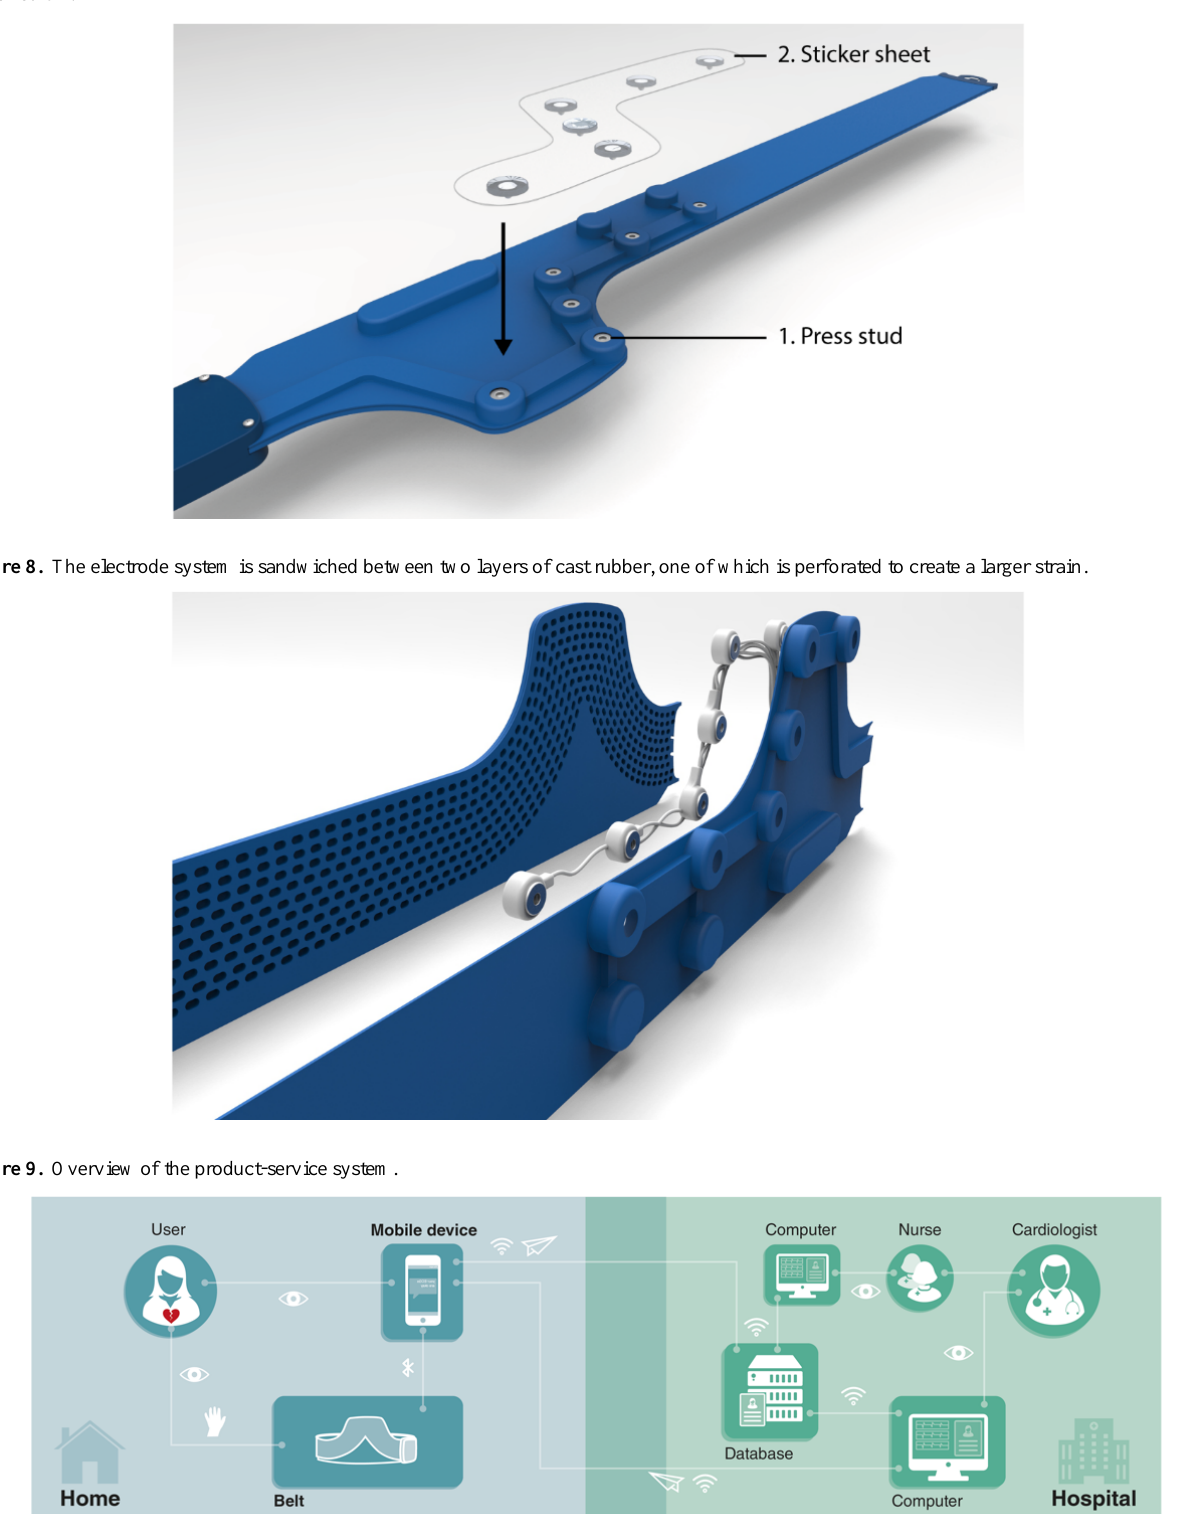
Figure 7. The electrodes are preplaced on a sticker sheet and connected to the belt using press studs. When the electrodes are connected, the sheet can be pulled off.